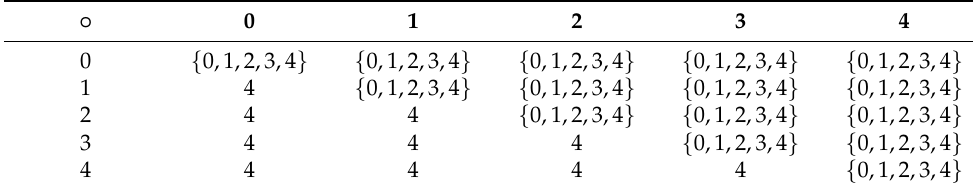
Table 8. Transitive quasi-hyper BZ